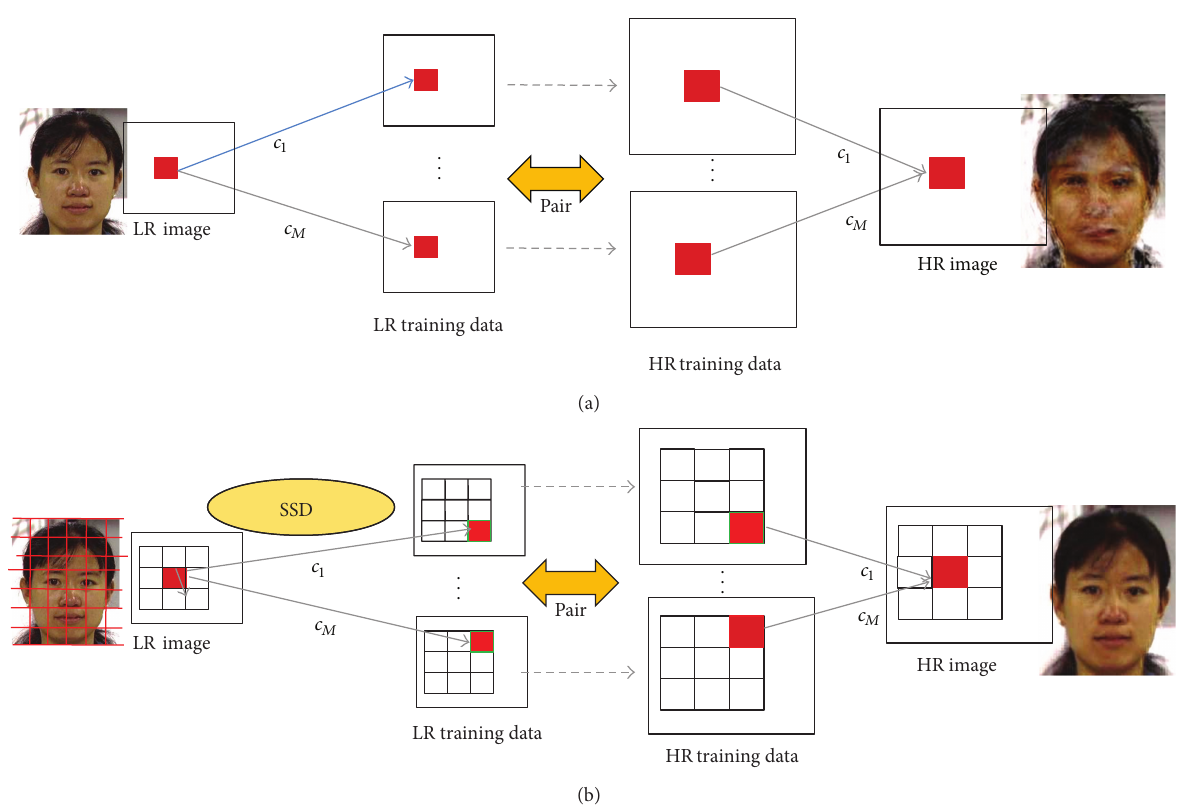
Figure 6: (a) Conventional face hallucination, (b) our proposed alignment-free patch-based face hallucination.